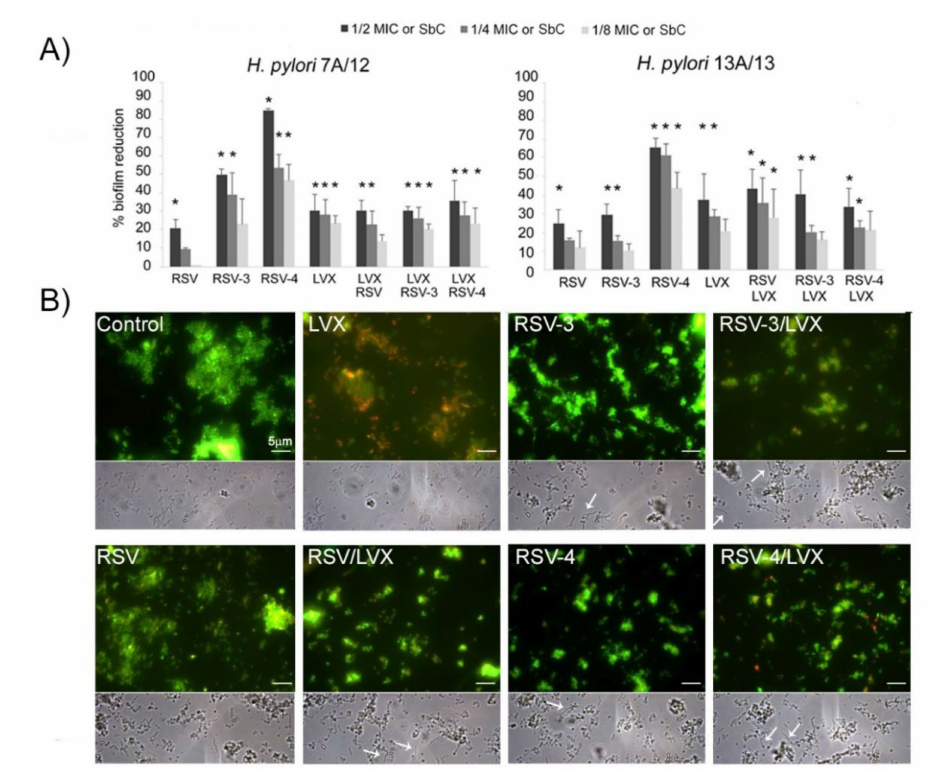
Figure 3. E ff ect of RSV, its derivatives (RSV-3 and RSV-4), and LVX at sub-inhibitory concentration (1 / 2, 1 / 4, 1 / 8MIC) and their combinations at sub-synergistic concentrations (SbC), against H. pylori 7A / 12 and H. pylori 13A / 13 biofilm formation. ( A ) Percentage of biofilm reduction of resistant strain 7A / 12 and MDR H. pylori 13A / 13 after treatments. * Statistically significant values with respect to the control. ( B ) Representative fluorescence (after Live / Dead staining) and phase contrast light microscopy images of H. pylori 13A / 13 biofilm treated with 1 / 4 MIC LVX, 1 / 4 MIC RSV, 1 / 4 MIC RSV-3, and 1 / 4 MIC RSV-4 and 1 / 4 sub-synergistic combinations of RSV, RSV-3, or RSV-4 and LVX and the untreated sample (control). Viable cells exhibit green fluorescence while dead cells exhibit red fluorescence. Arrows indicate the elongated forms of H. pylori cells after treatment with RSV, RSV-3, and RSV-4 alone and combined with LVX. Original magnification 1000 × (scale bar: 5 µ